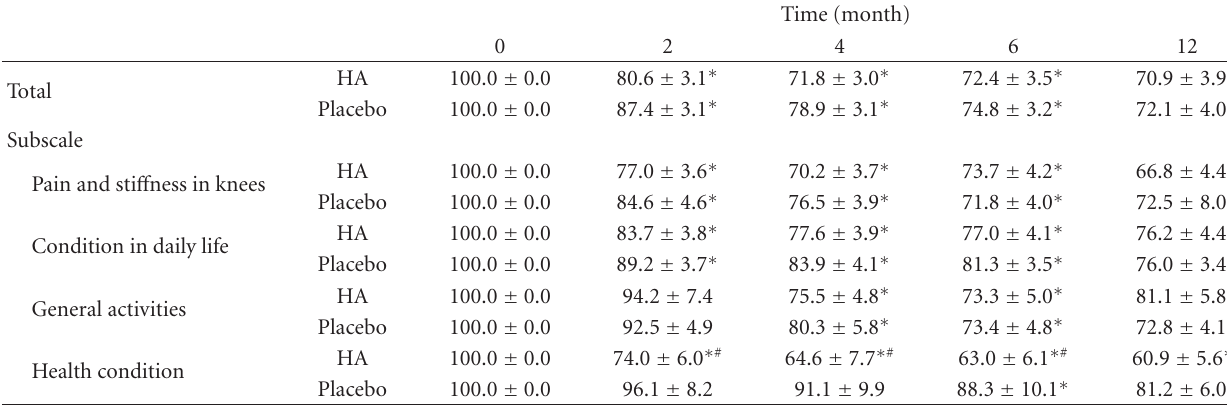
Table 2: Change of JKOM score during study period.